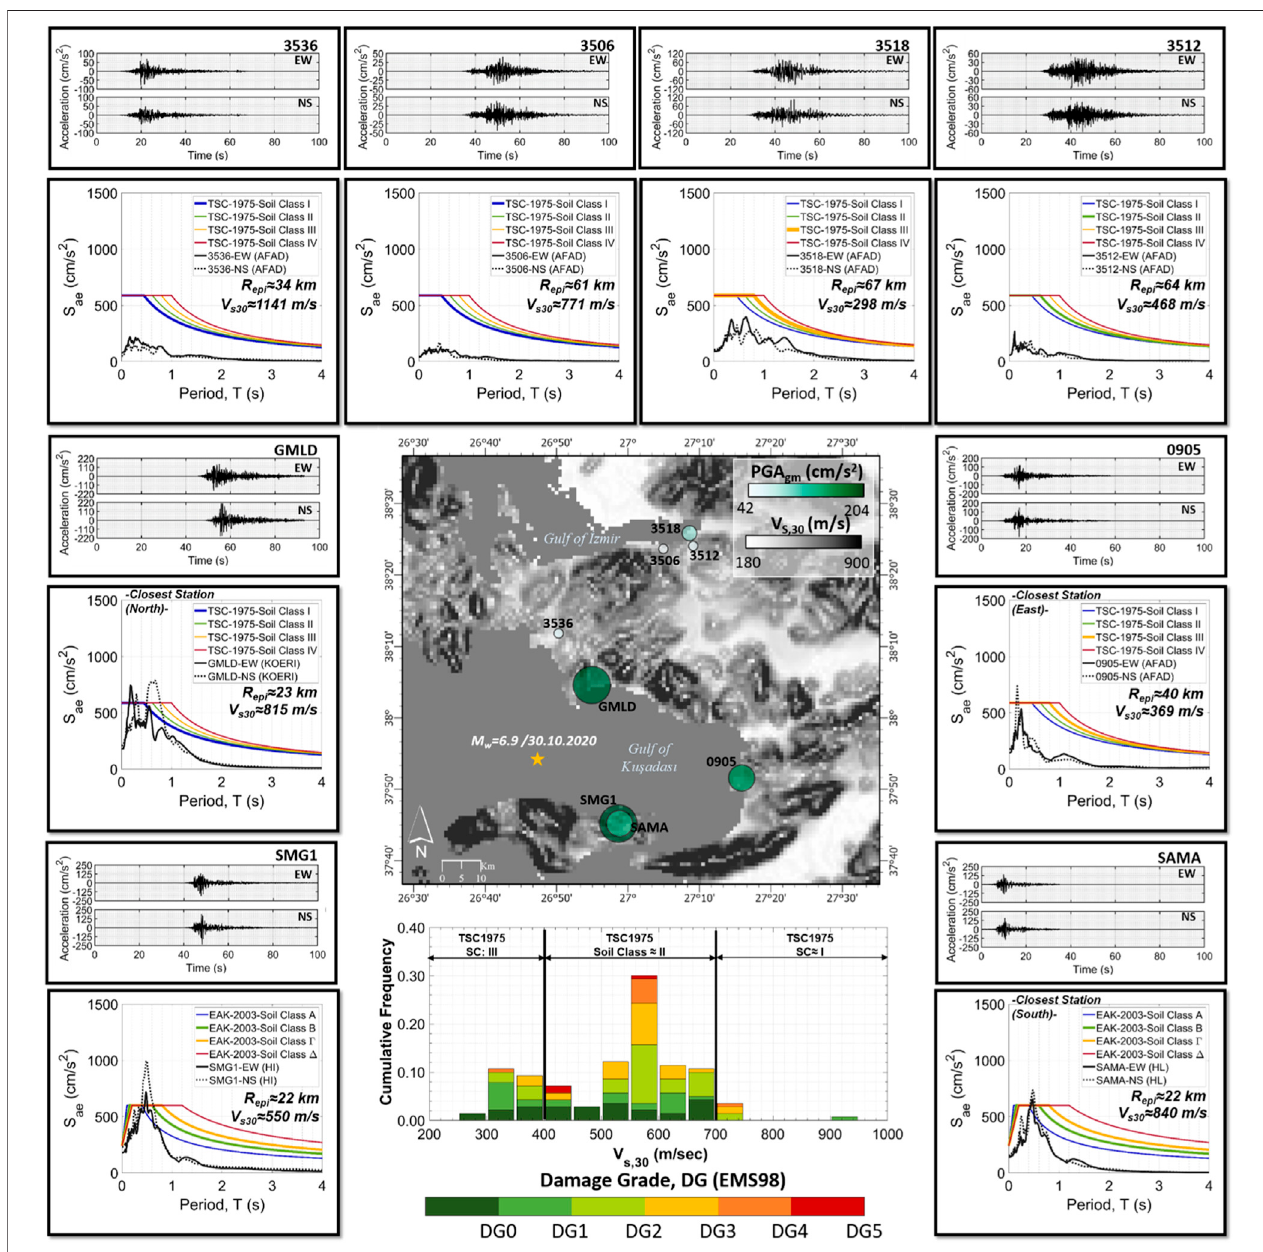
FIGURE 8 | The map of USGS topography based V S30 values together with the geometrical mean of recorded PGAs of several stations that are close to the examined buildings in the database, their strong ground motion time histories of horizontal components and their response spectra (5% of damping ratio) compared to design spectra (EAK2003 for Greece and Turkish seismic provision, 1975 for Turkey). The histogram shows the distribution of V S30 values of the inspected buildings with respect to their damage grades. (PGA gm = Geometrical mean of peak ground acceletation; V S30 = average shear wave velocities for the upper 30 m depth; R epi = Epicentral